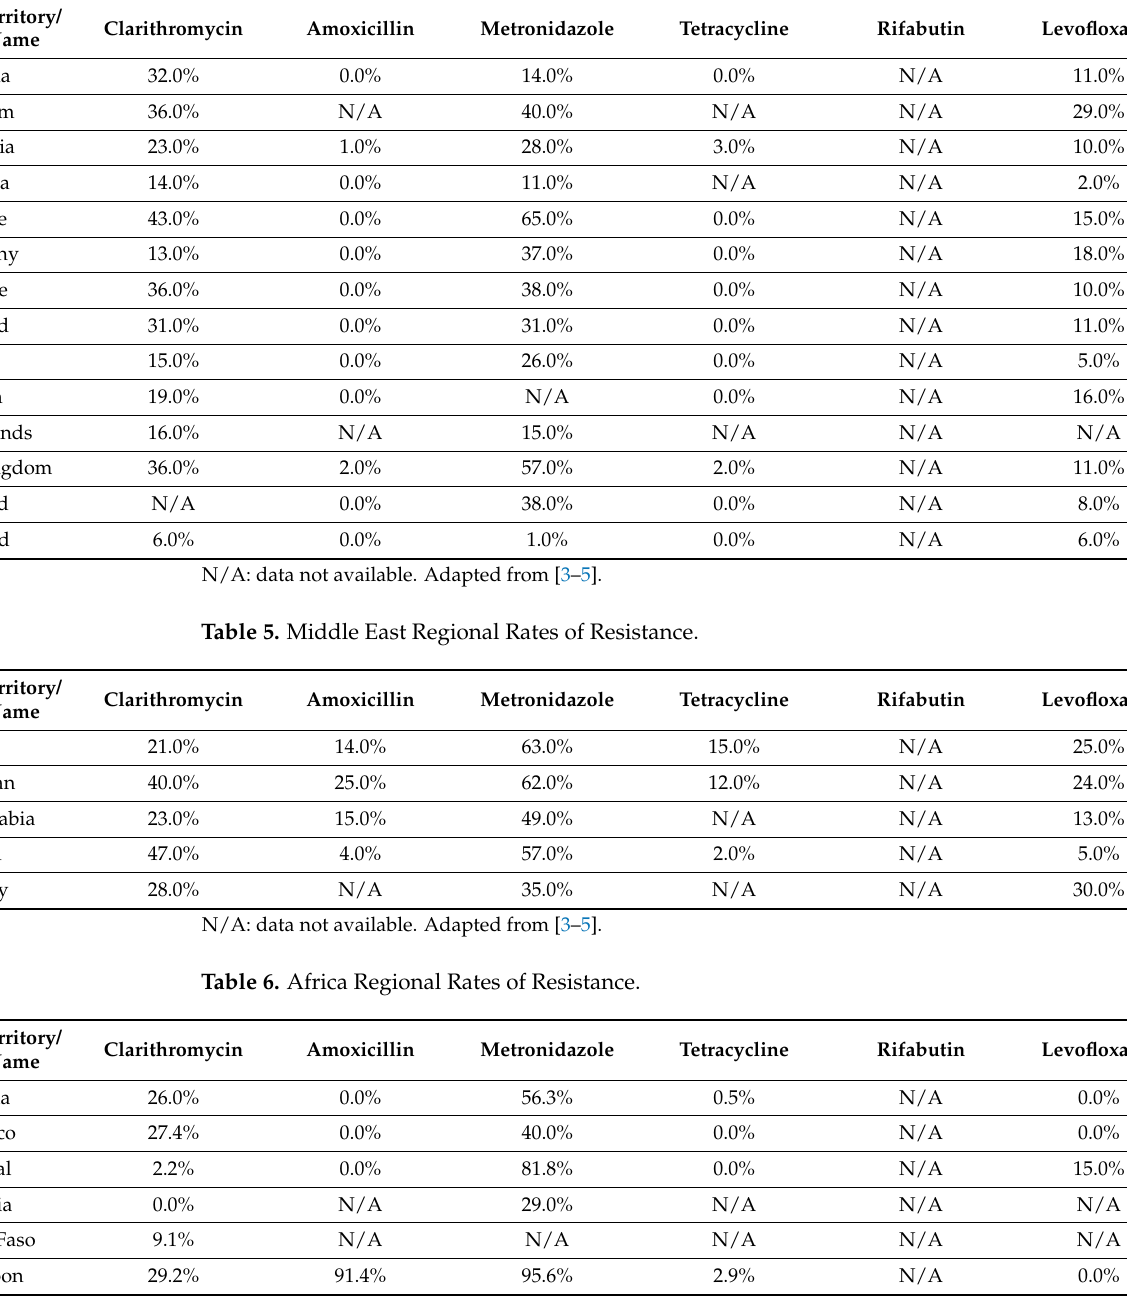
Table 4. Europe Regional Rates of Resistance.